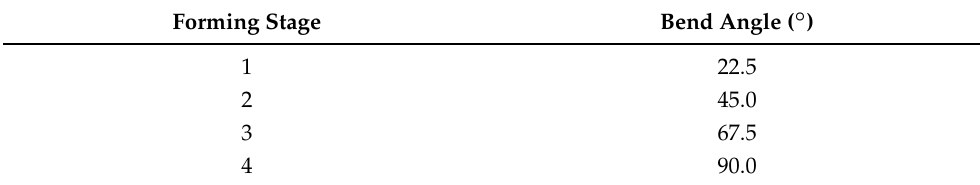
Table 2. Forming stage information’s for producing